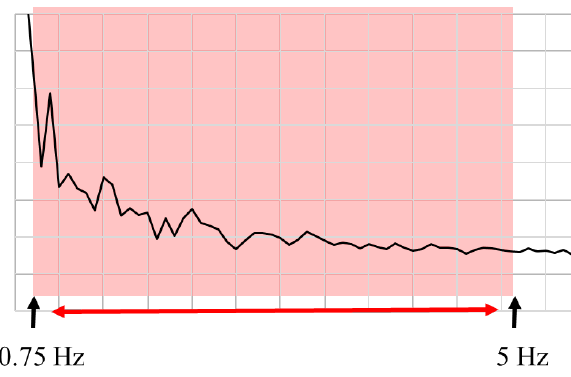
Figure 5. Average magnitude spectrum of 20 different average point signals (duration: 12.8